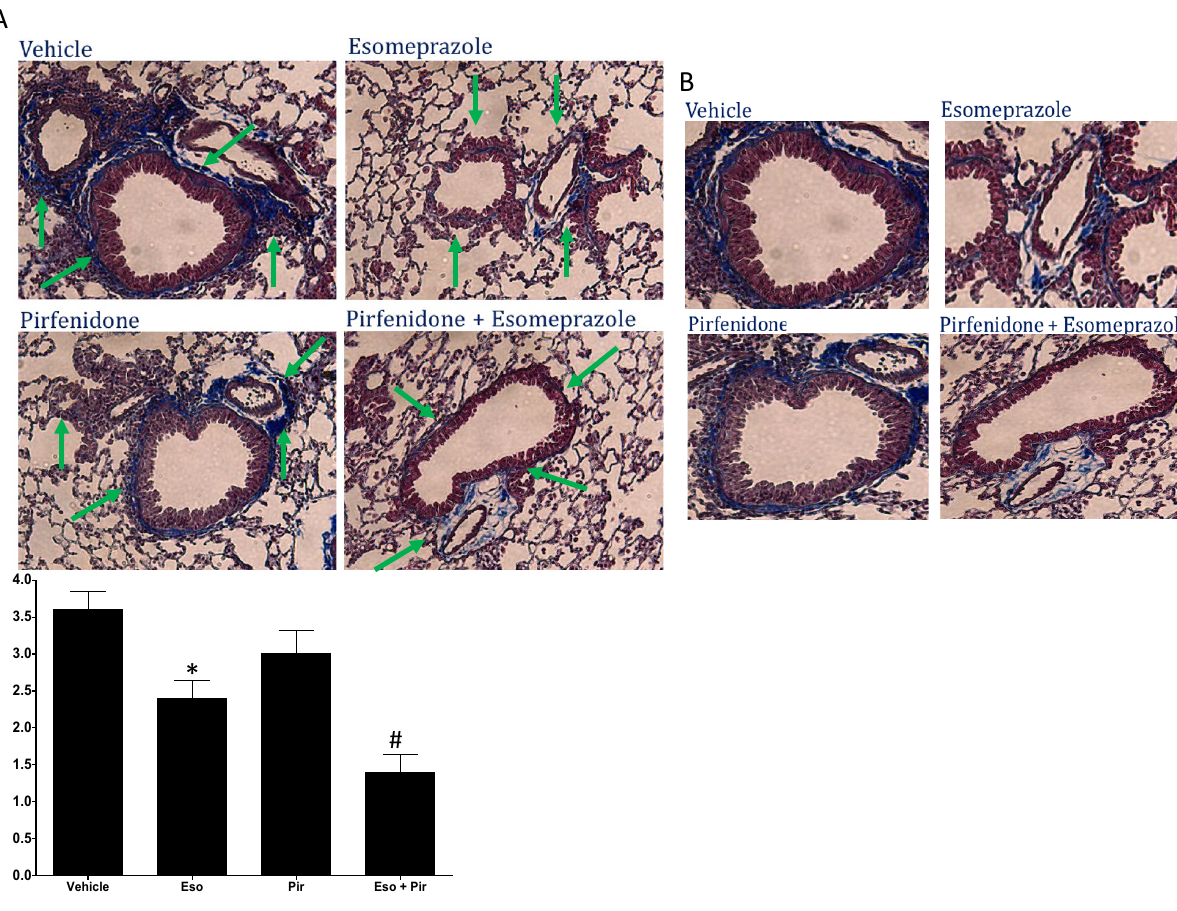
Figure 7. ( A ) Masson’s trichrome stain demonstrating antifibrotic effect of esomeprazole, pirfenidone or the combination. C57BL/6J mice were intratracheally challenged with adenoviral vector encoding TGFβ (6 × 10 6 pfu) and orally treated with vehicle (dH 2 O), esomeprazole (Eso; 30 mg/kg), pirfenidone (Pir; 100 mg/kg) or esomeprazole (30 mg/kg) and pirfenidone (100 mg/kg) combination (Eso + Pir) starting from 10 days post-challenge. The animals were treated daily until the day of necropsy (day 28). The combination therapy effectively suppressed lung fibrosis (shown as blue stain) compared to esomeprazole or pirfenidone monotherapy (arrows). In panel ( B ), zoomed out images of the tissue included in the analysis are shown. The fibrosis scores are shown as a bar graph. Data is from 5 animals/group. *p < 0.05 compared to the vehicle group and # p < 0.05 compared to pirfenidone